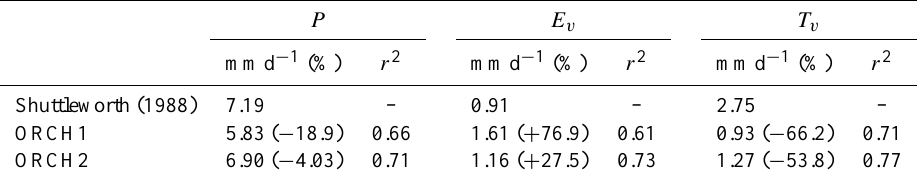
Table 6. Comparison of the mean annual values (all in mmd − 1 ) of precipitation ( P ), transpiration ( T v ) and evaporation of water over the leaves ( E v ) between measurements by Shuttleworth (1988) near Manaus (Ducke Reserve, see Table 5 for the coordinates) and results from the two simulations ORCH1 and ORCH2, over the mean time period September 1983–September 1985. Values between brackets and r 2 are, respectively the mean annual relative error (%) and the coefficient of correlation between simulation and observation.